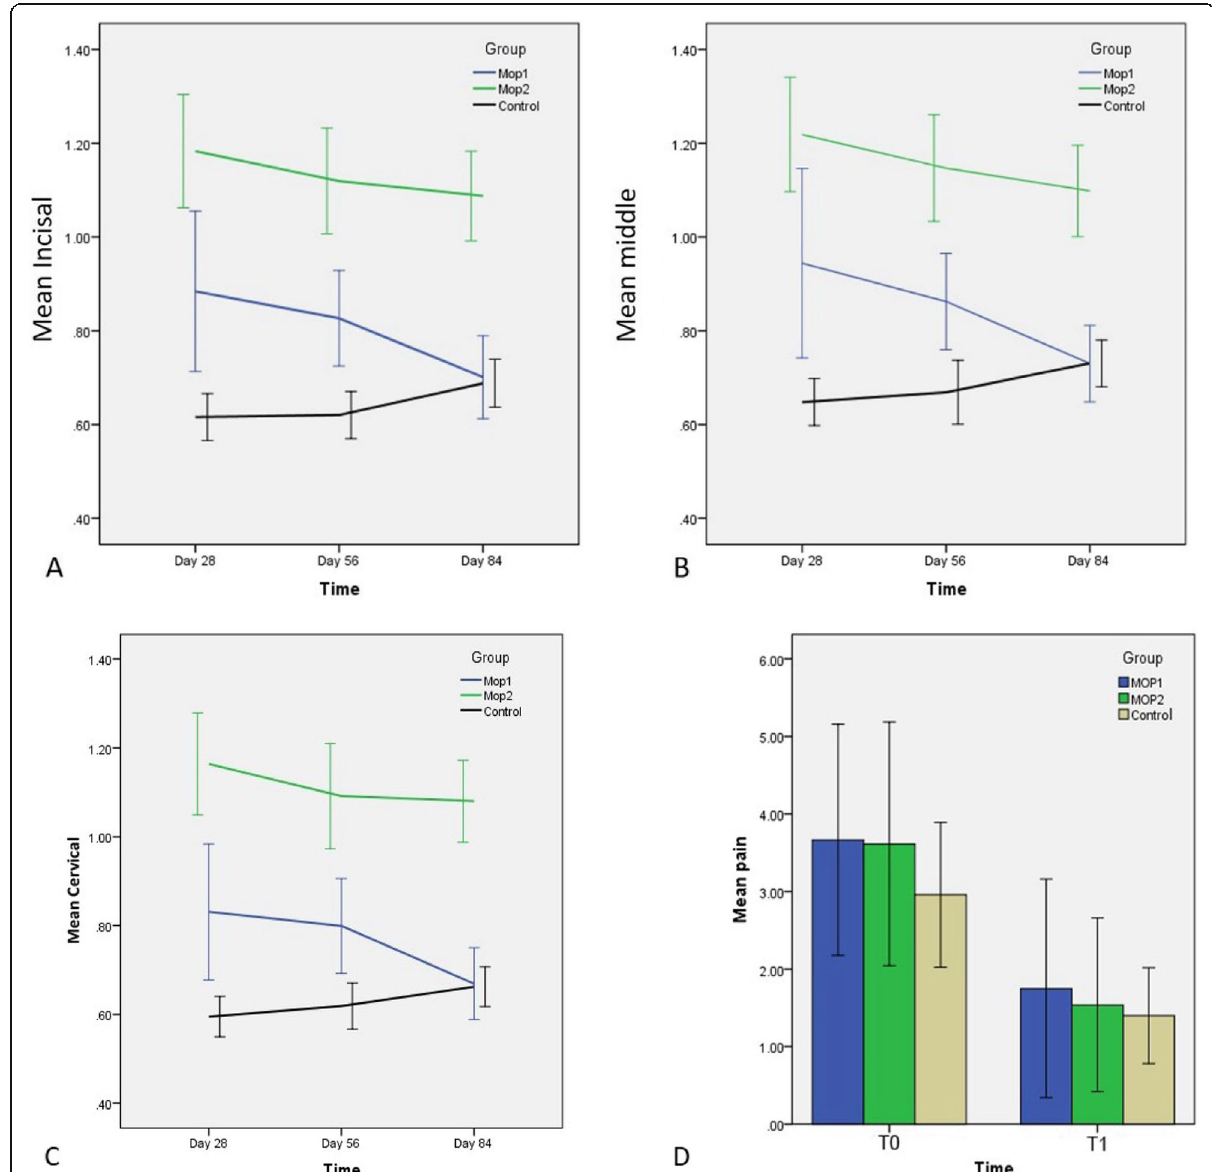
Fig. 3 Comparison of mean values of the canine movement among three study groups over the time at the incisal, middle, and cervical points ( a , b , c respectively). Comparison of the mean pain scores on VAS among the three study groups at two time intervals ( d ). T0, on the day of MOP; T1, 24 h after MOP